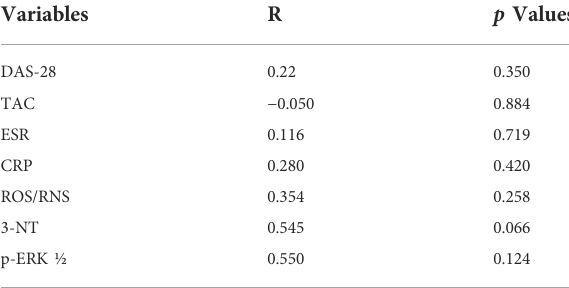
TABLE 2 Correlation of ER- α with various selected